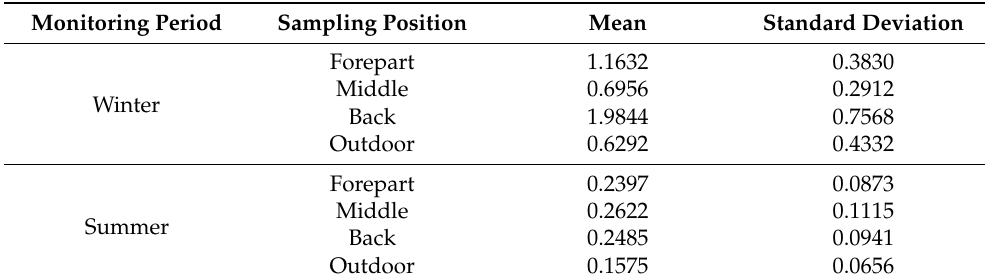
Table 1. Ammonia concentration at different monitoring positions (mg/m 3